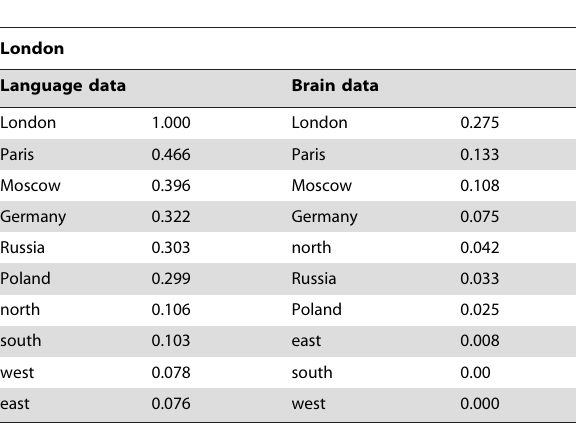
Table 1. Partial orders for London derived from the WordNet semantic similarities of Figure 2 and the conditional probability estimates for the brain data of Figure 1.